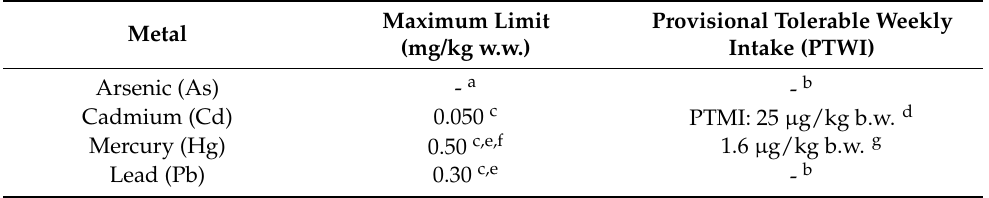
Table 1. Maximum limits and tolerable weekly intakes for contaminants in muscle fillet of fish for arsenic (As), cadmium (Cd), mercury (Hg), and lead